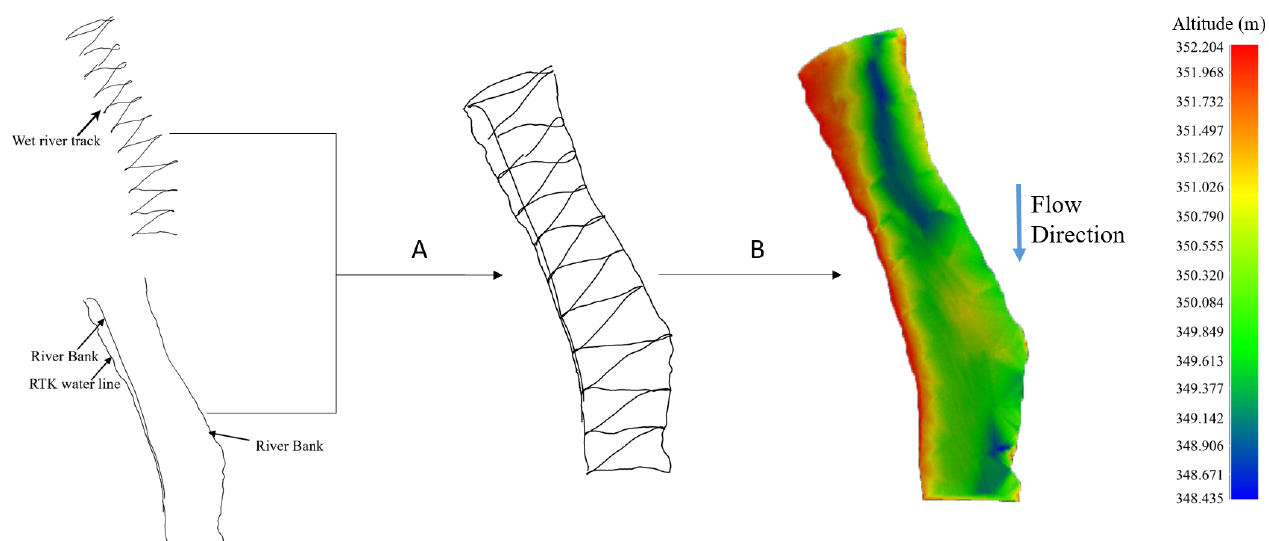
Figure 13. Wet bathymetry processing ( a : merging the wet bathymetry transects which were measured using the ADCP with the RTK line as well as the boundary, b : volumisation of the merged products achieved through linear